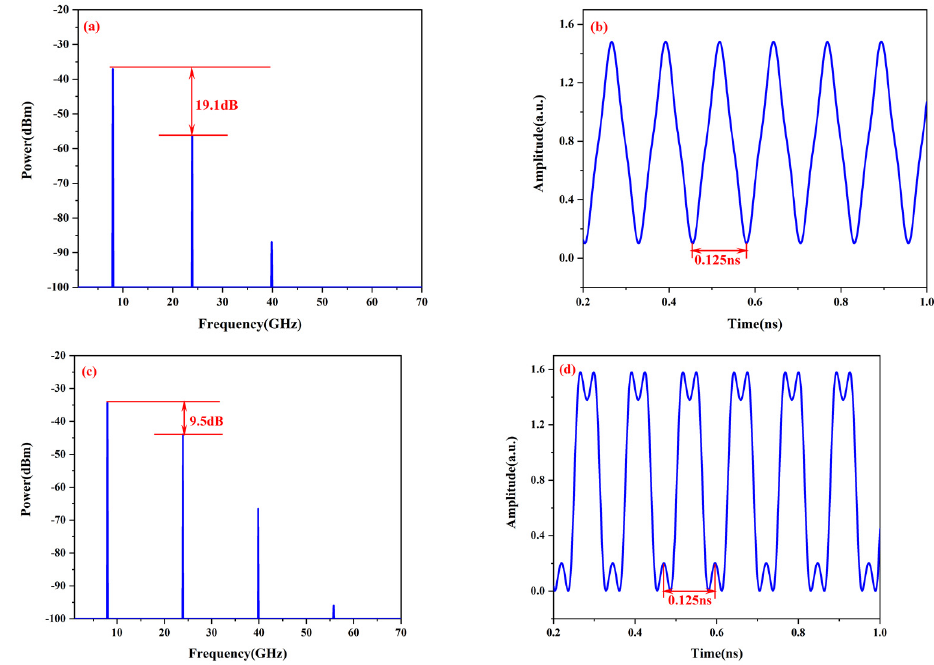
Figure 4. Simulation results of the ( a ) PD output triangular wave spectrum, ( b ) PD output time domain triangular waveform, ( c ) PD output square wave spectrum, ( d ) PD output time domain square waveform.